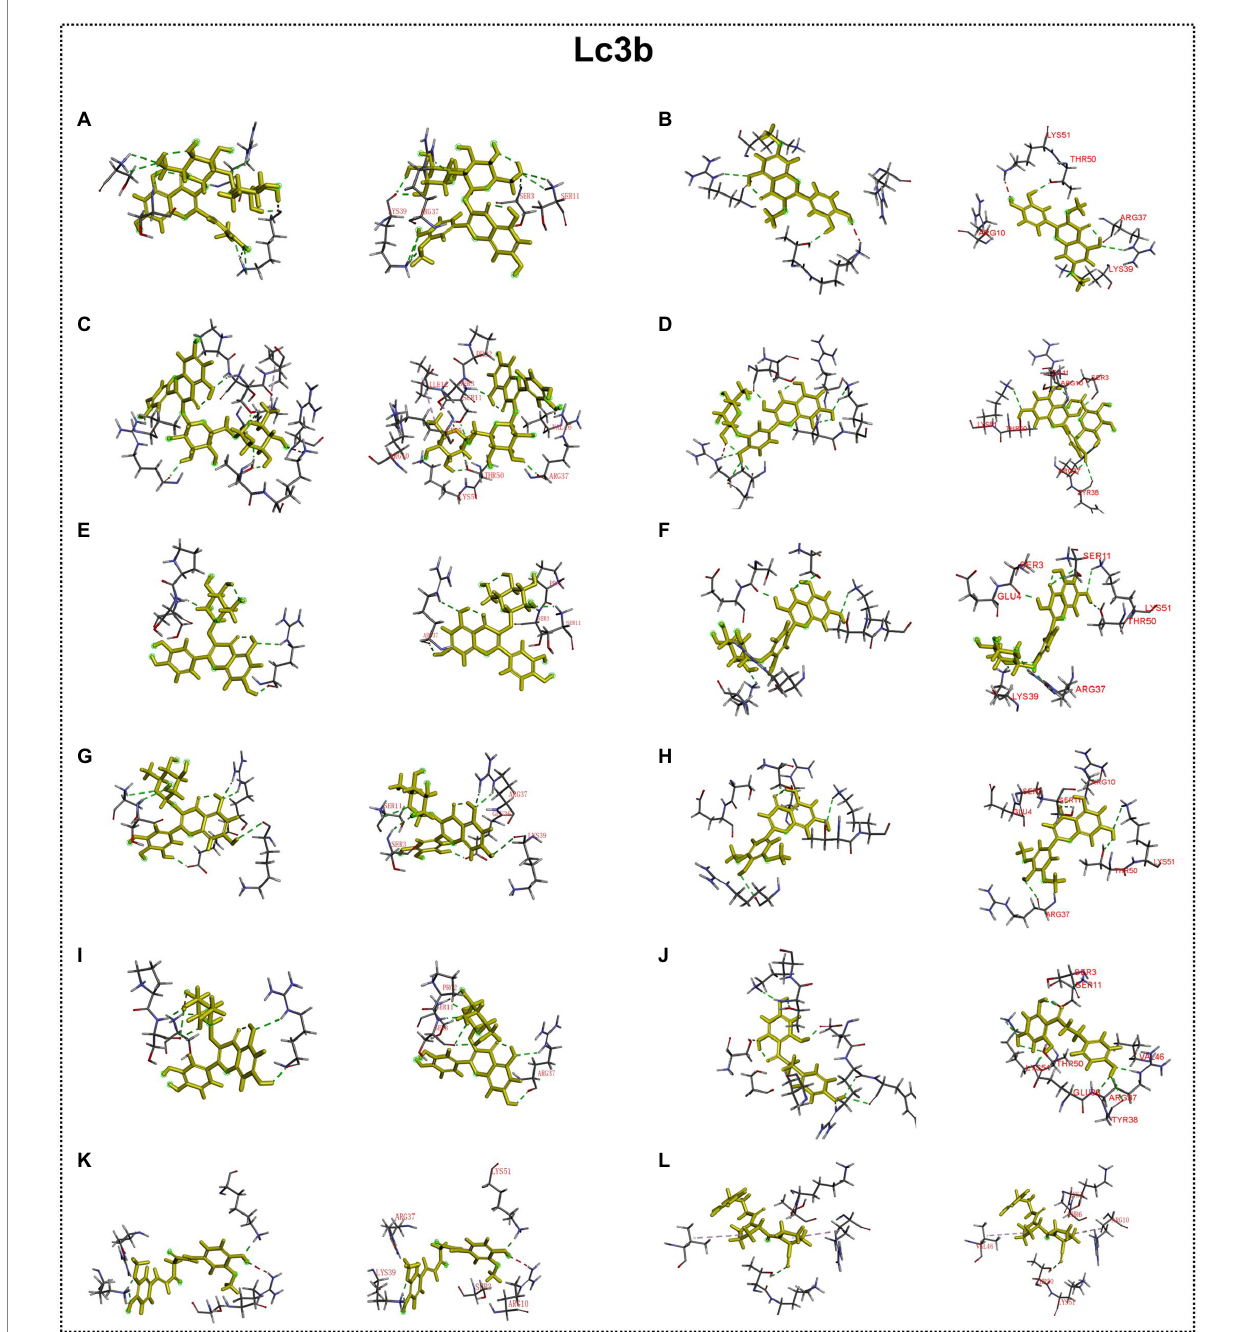
FIGURE 11 Docking simulation of the interaction between main flavonoid compounds of ECoL and the receptor Lc3b in general overview and local overview. Isorhamnetin-3-O-neohespeidoside (A) , di-O-methylquercetin (B) , rutin (C) , quercetin-3’-O-glucoside (D) , isoquercitrin (E) , spiraeoside (F) , myricitrin (G) , tricin (H) , hyperoside (I) , phloretin (J) , curcumin (K) , and KYP-2047 (L) were used as molecularly docked